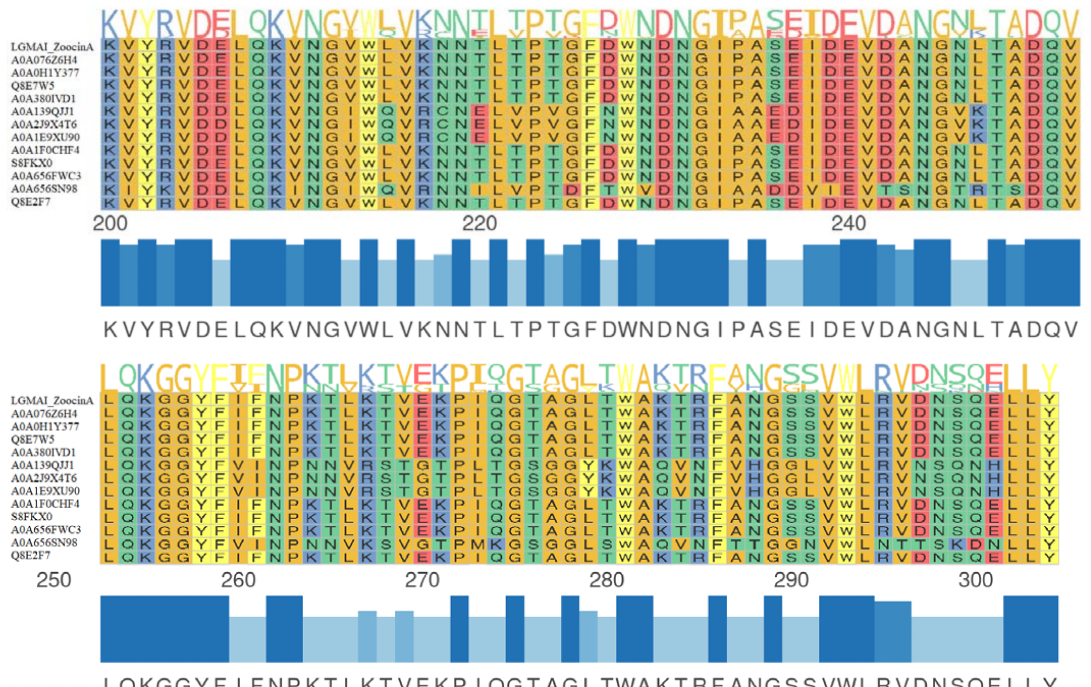
Figure 4. Multiple sequence alignment between the LGMAI’s putative zoocin A and 12 other zoocin A sequences obtained from the Uniprot database. Amino acid conservation can be observed in the target recognition domain. Protein sequence logos are at the top of the representation, while multiple sequence alignments are in the middle, and the identity bars and consensus sequences are at the bottom.